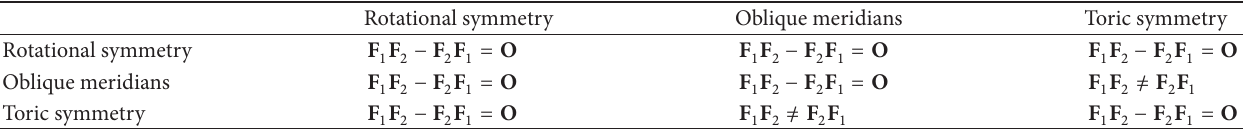
Table 1: Aligned meridians and commuting surface power matrices. The reader can match the symmetry on respective lens surfaces of meridians in the first column with those in the first row. Meridians have been aligned on surfaces where possible. From (9) power matrices commute for aligned meridians since their power matrices have equal eigenvectors: F 2 = 𝑝 F 1 + 𝑞 I . At not-equal signs, the meridians from opposite lens surfaces cannot physically